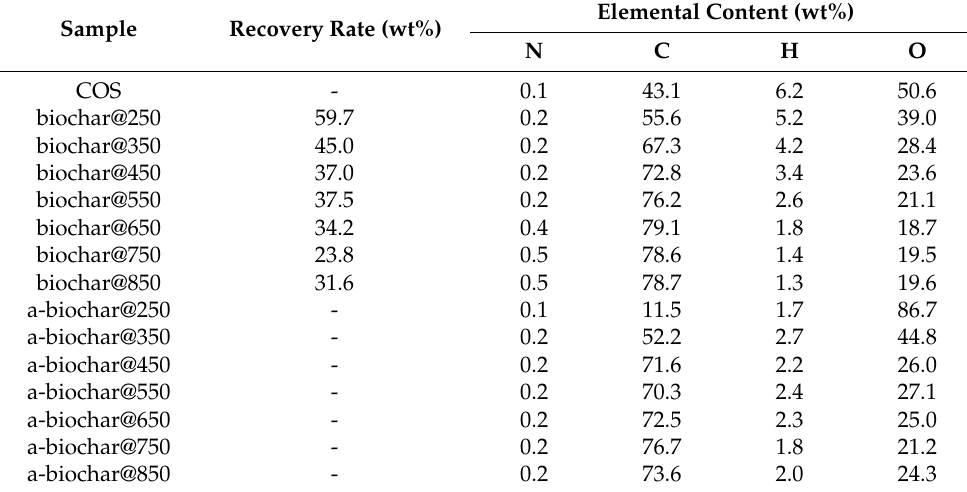
Table 1. Weight recovery and elemental composition of